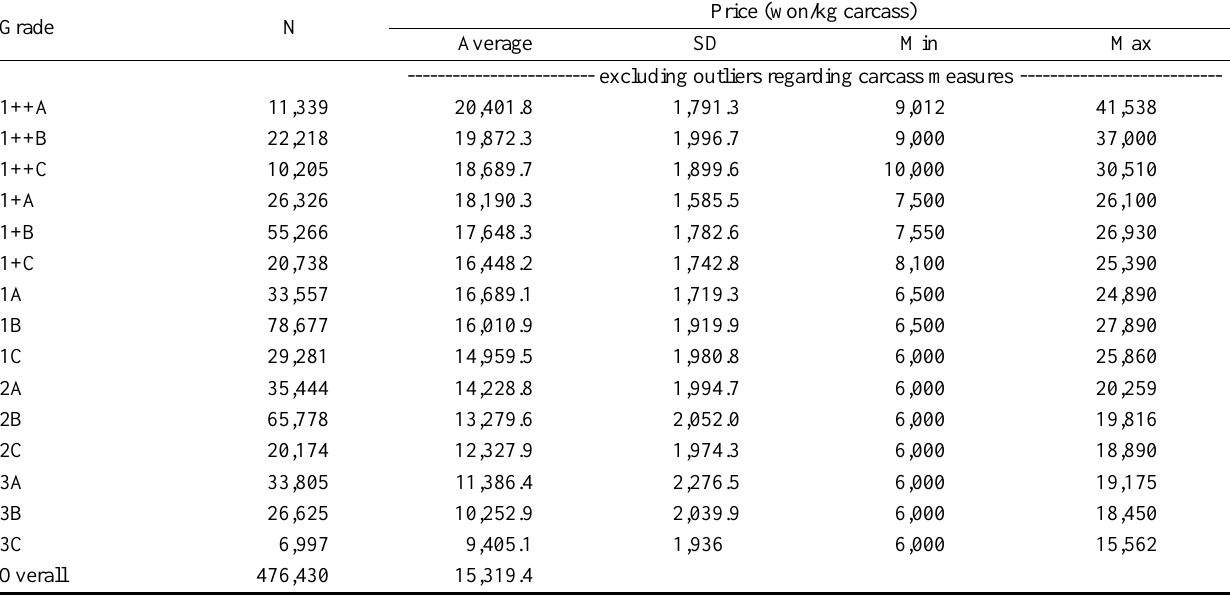
Table 2. Average bid price of the Hanwoo carcasses (won/kg) by final grades without grade ‘D’ and with price over won 6,000/kg